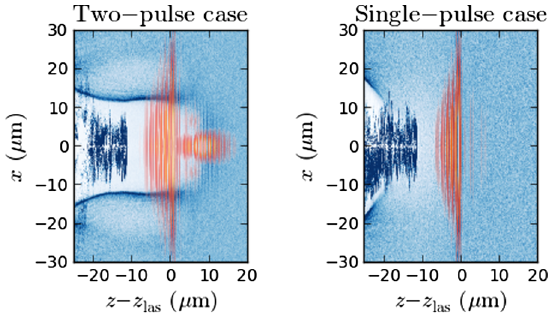
FIG. 2. Upper panel: density profile (blue), laser waist (red), and trajectories of a few injected electrons (black) in the PIC simulation. Lower panel: RMS divergence of the bunch in the x and y directions. (The laser is polarized along x .)